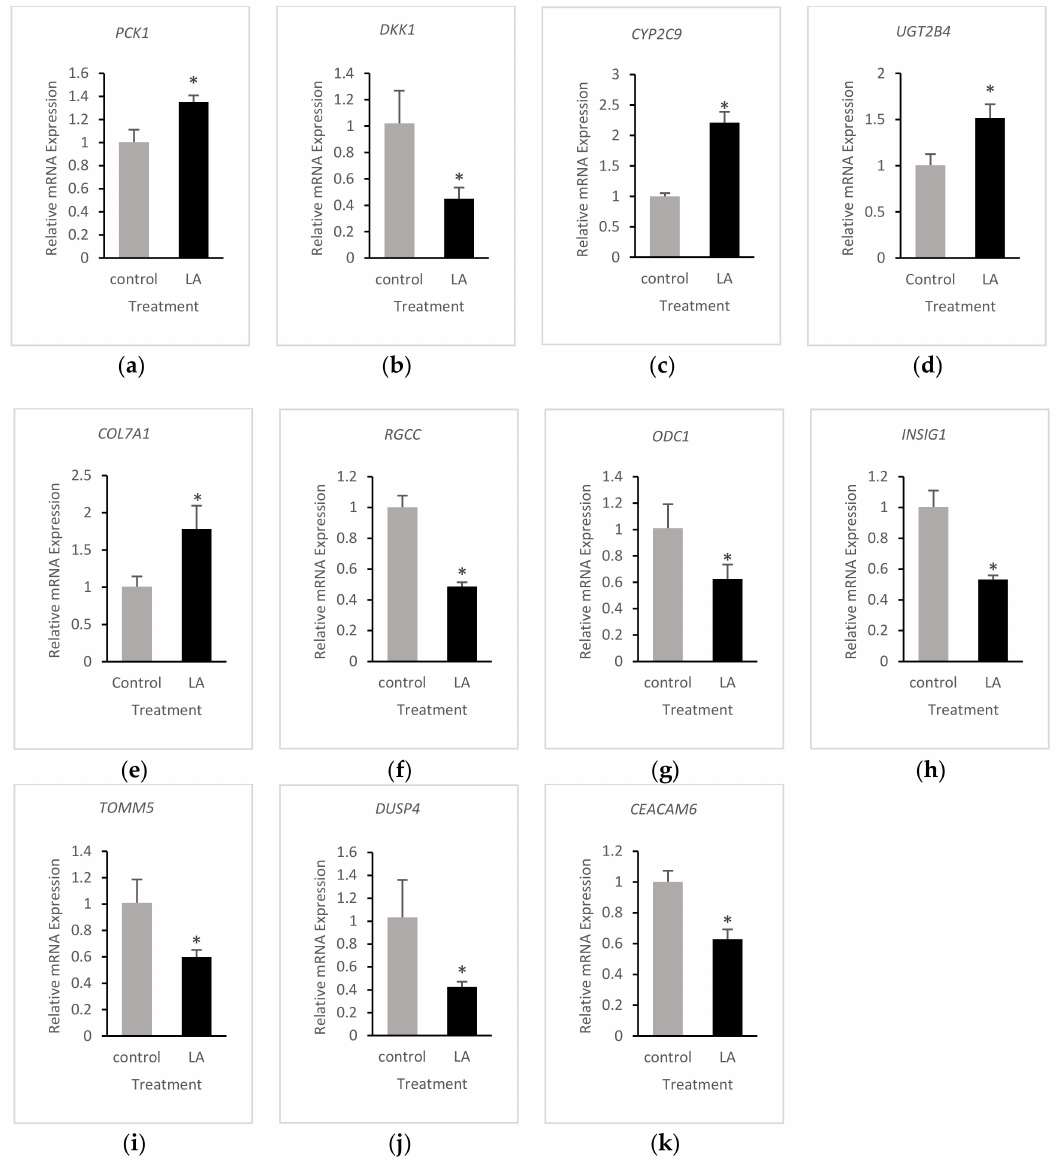
Figure 6. Quantitative Real-time PCR validation of RNA-seq results in LA-treated cells ( a – k ). qRT-PCR of representative DEGs from RNA-seq data. Relative mRNA expression of genes is presented in LA-treated (LA) Caco-2 cells with statistical significance of * p < 0.05 compared to untreated (control) cells. Results were normalized to